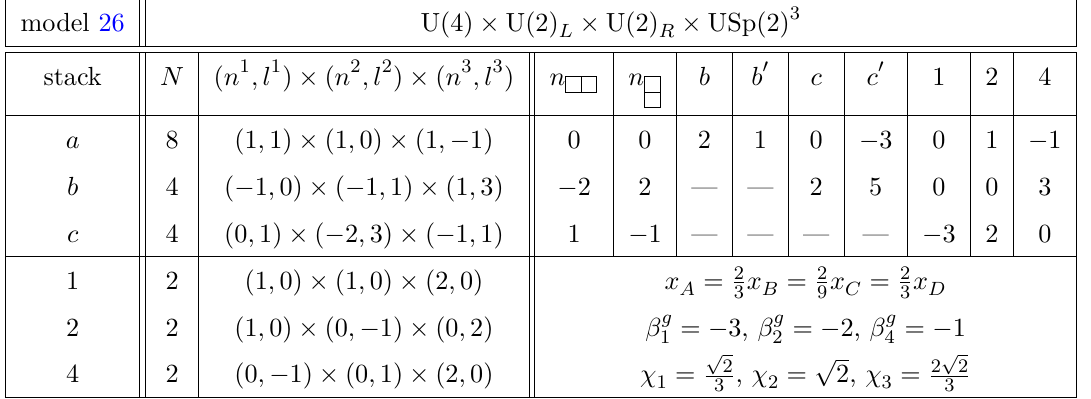
Table 26 . D6-brane configurations and intersection numbers of Model 26, and its MSSM